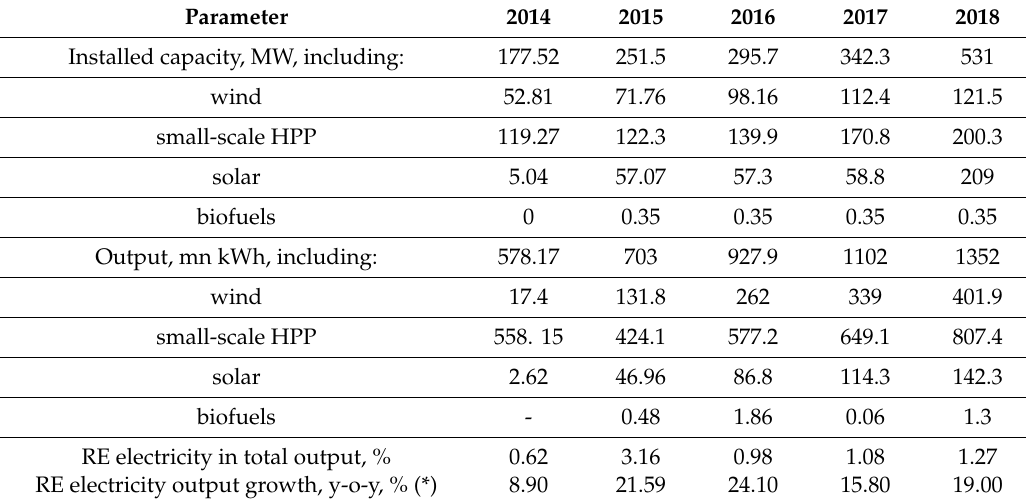
Table 9. Deployment of RE in Kazakhstan (Source: author, based on annual reports of Kazakhstan’s Ministry of Energy, http: // energo.gov.kz / index.php?id =